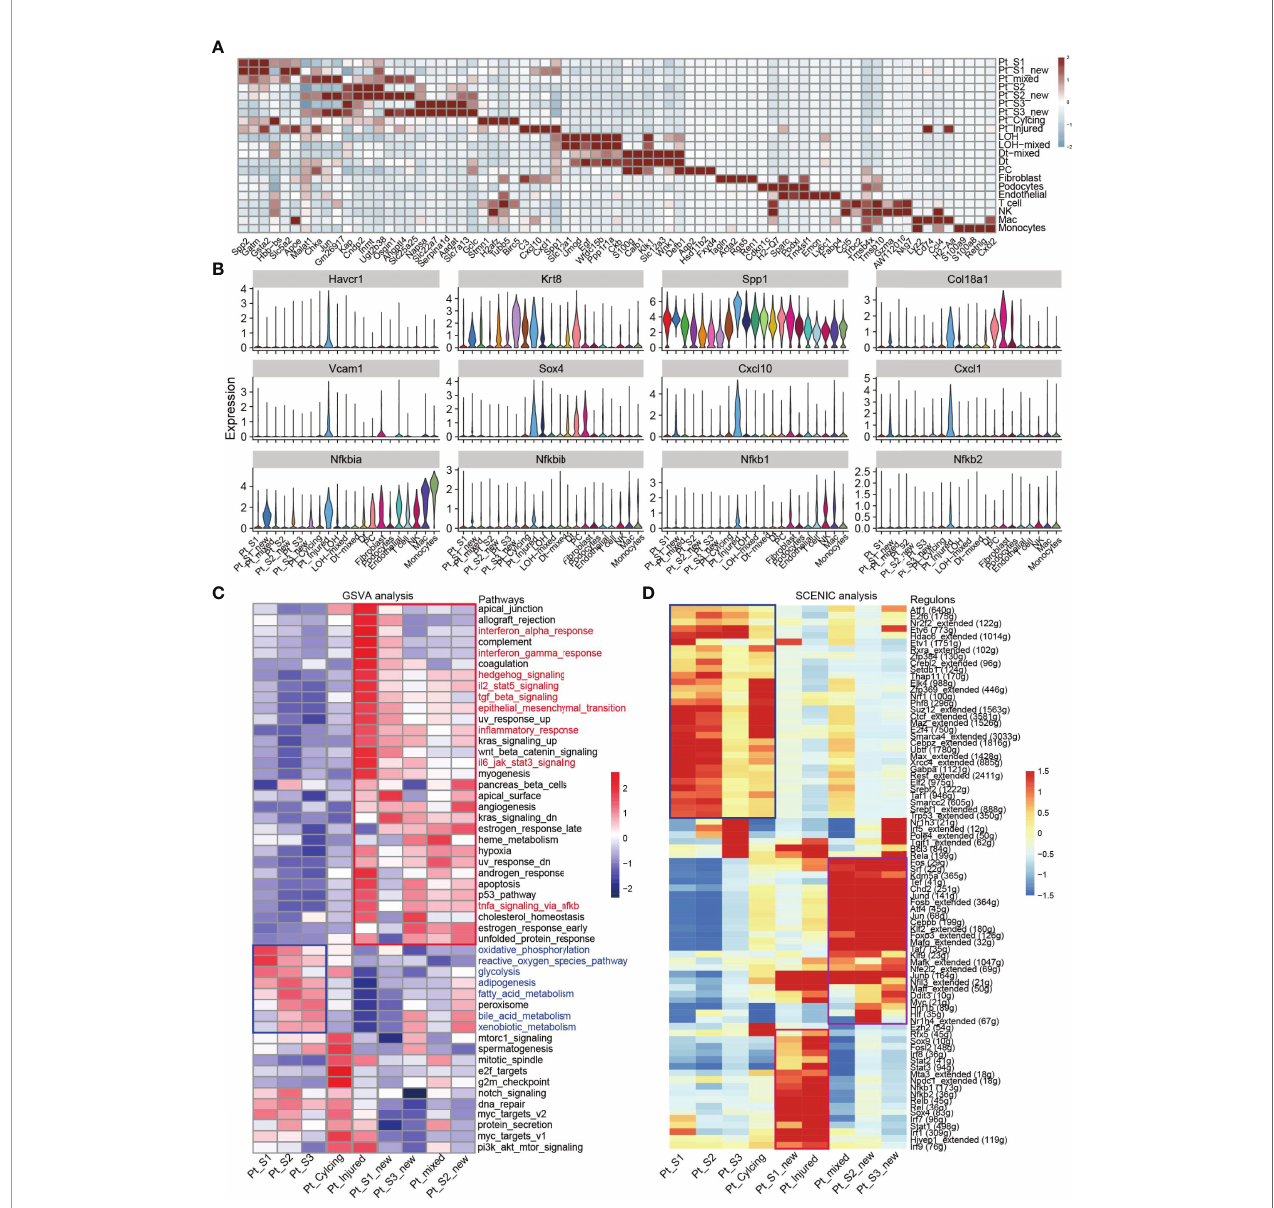
FIGURE 2 | Transcriptomic features of distinct cell types. (A) Top 4 differentially expressed genes in 21 cell types. (B) The expression level of representative kidney injury and in fl ammatory signatures in 21 cell types. (C) Enriched signaling pathways in PTC-new, injured PTC and normal PTC, estimated by GSVA. (D) Enriched regulons in PTC-new, injured PTC and normal PTC, estimated by